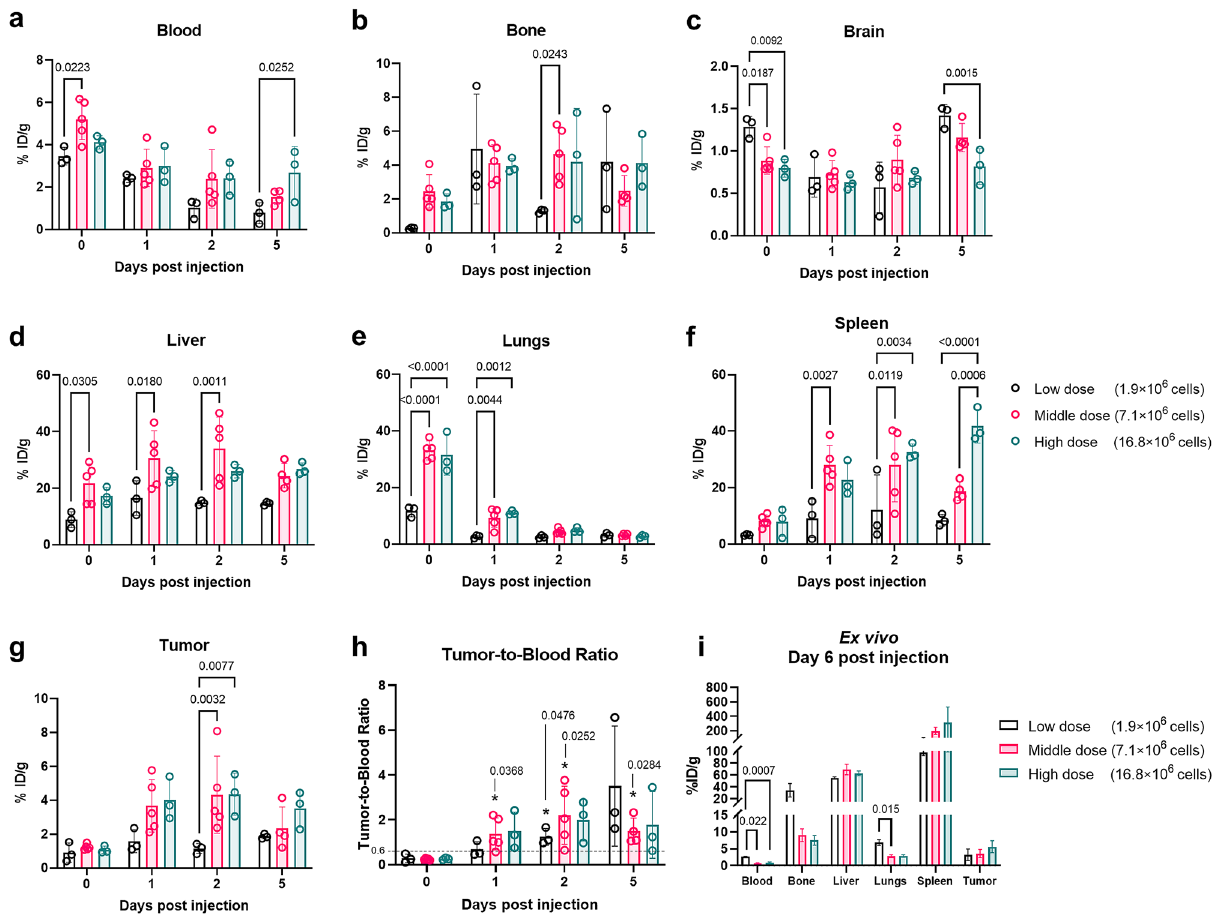
Figure 4. Tissue biodistribution of 89 Zr-oxine labeled huLym-1-A-BB3z-CAR T-cells dose escalation. Significant changes in %ID/g overtime were observed in all regions. ( a – g ) In vivo blood, bone, brain, liver, lungs, spleen, and tumor %ID/g of Raji-bearing NSG mice administered with low (mean ± SD: 126.7 ± 2.5 kBq, 1.87 ± 0.04 × 10 6 cells), middle (542,6 ± 92.1 kBq, 7.14 ± 0.45 × 10 6 cells) or high dose (1491.7 ± 36.1 kBq, 16.83 ± 0.41 × 10 6 cells) of 89 Zr labeled huLym-1-A-BB3z-CAR T-cells (Low dose, n = 3 mice; Middle dose, n = 5 mice; High dose, n = 3 mice). Columns with error bars indicate means and standard deviations (SD) and open circles as individual data points. ( h ) Tumor-to-blood ratio obtained by dividing tumor %ID/g by blood %ID/g to account for cell signal accumulation in extravascular tumor tissue. Significant cell accumulation was observed by beginning on day 1 to day 5 in NSG mice that received the middle dose, and in mice that received low dose on day 2, by one-sample t-test vs. 0.6 threshold to overcome the enhanced permeability and retention (EPR) effect. ( i ) Ex vivo biodistribution %ID/g of low, middle, and high CAR T-cell doses on day 6 post CAR T-cell injection. Columns and error bars indicate means and SD, respectively. Statistically significant findings between comparisons are indicated with p-values above brackets. A value of p < 0.05 was used to indicate statistical